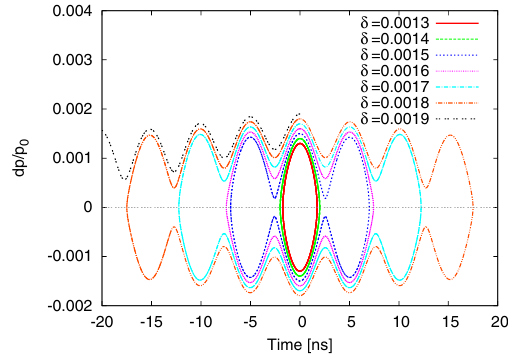
FIG. 3. Longitudinal phase space in the RHIC ion runs. The total voltages for the 28 MHz and 197 MHz RF systems are 0.3 MV and 3 MV.